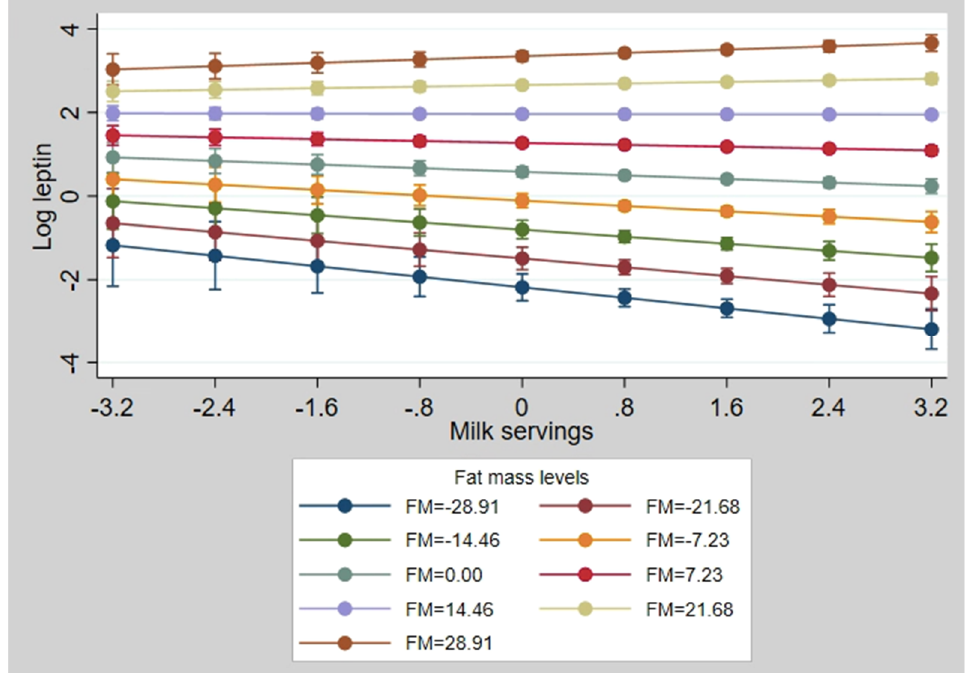
Figure 1. Interaction plot for log leptin at different fat mass (FM) levels. The values for milk servings, log leptin, and FM are presented in z-scores.